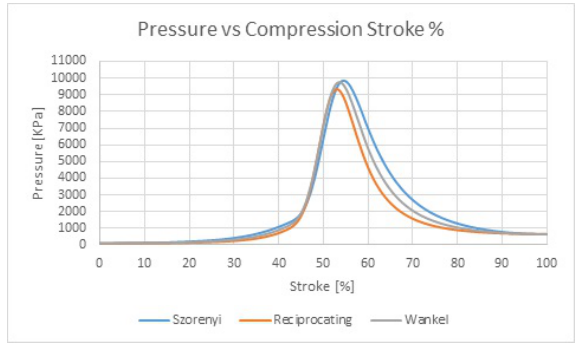
Fig. 9: Pressure comparison in a complete cycle of the Szorenyi, Wankel and reciprocating engines